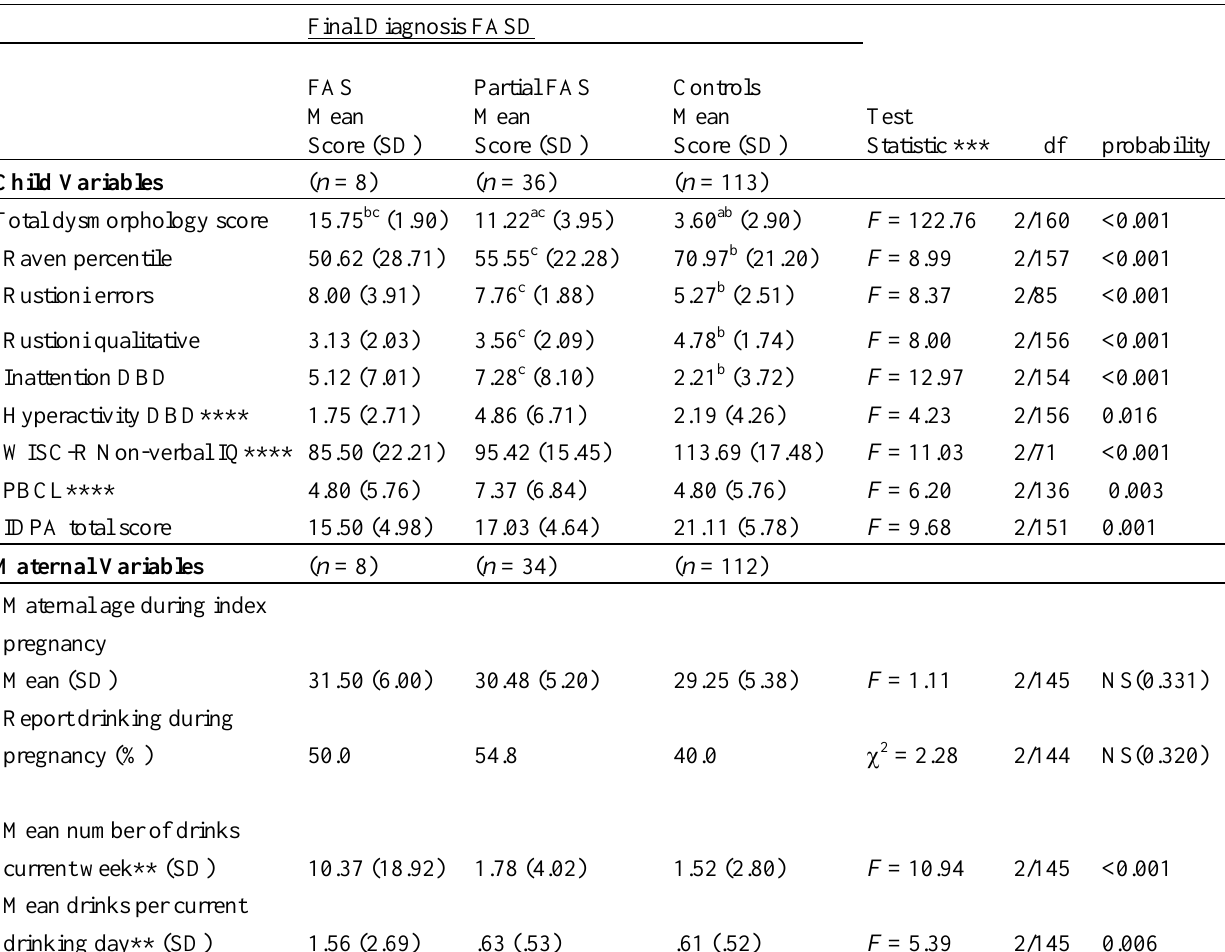
Table 2. Demographic and behavioral indicators of controls and children with a FASD diagnosis and comparisons of maternal age and drinking measures across groups: Lazio Region,